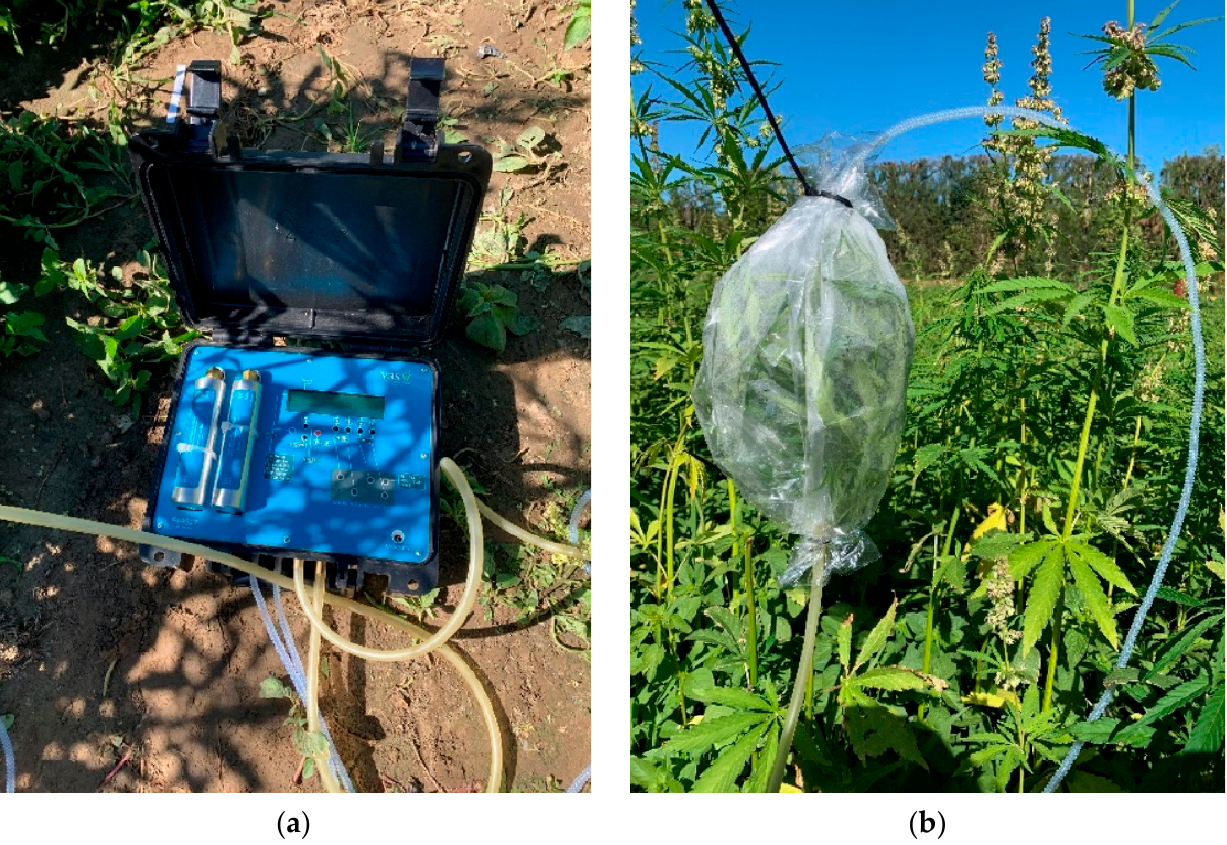
Figure 2. The volatile collection procedure: ( a ) Portable PVAS22 pump; ( b ) plant material bagged and fastened to create an enclosed system for volatile collection.